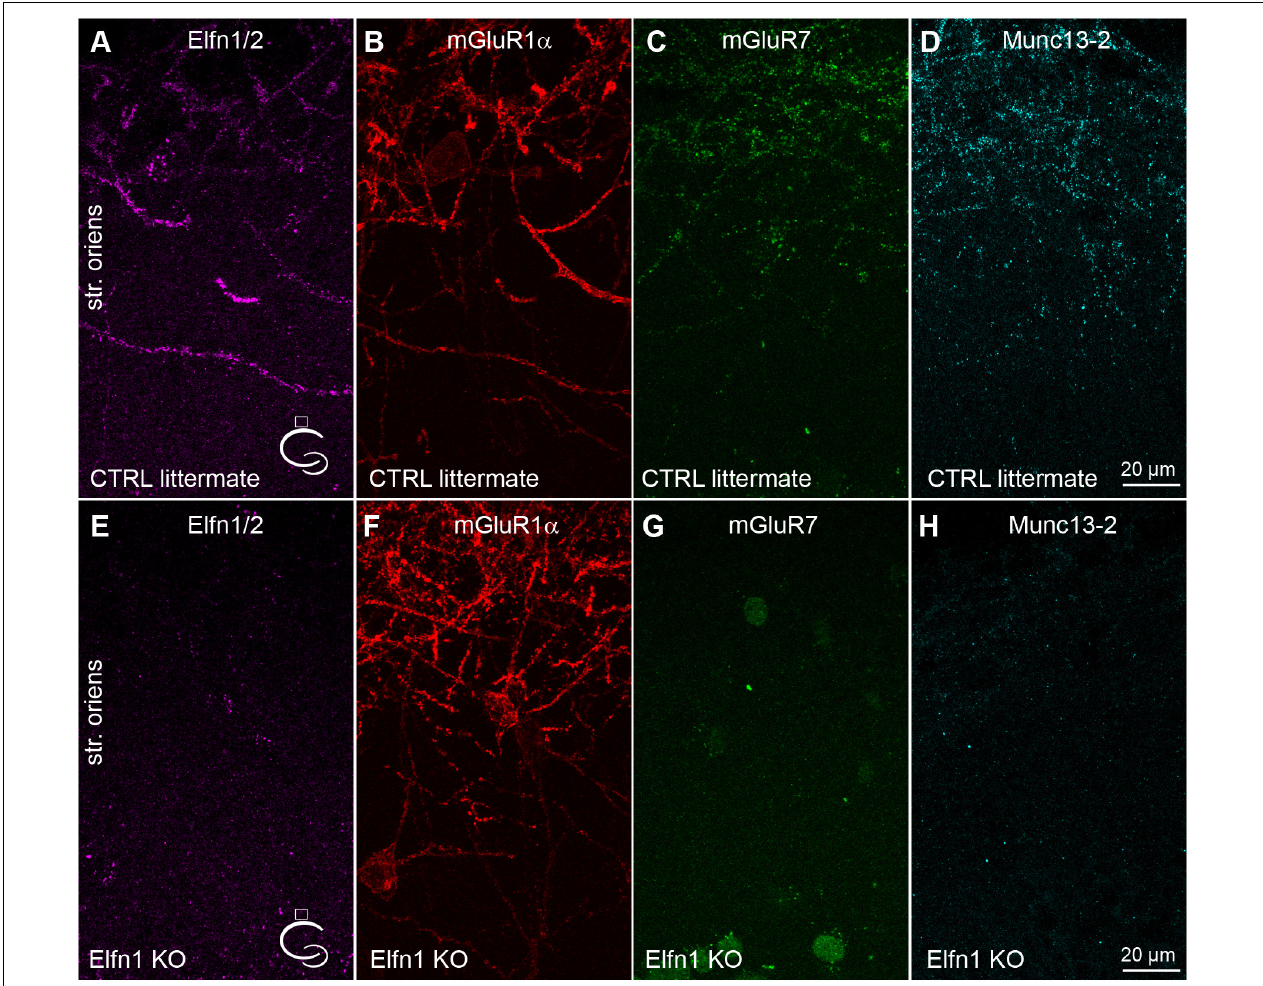
FIGURE 2 | Munc13-2 and mGluR7 are missing in Elfn1 knock-out mice. (A–D) Immunolabeling for Elfn1/2 (A) , mGluR1 α (B) , mGluR7 (C) and Munc13-2 (D) in the dorsal CA1 region of a littermate control mouse shows intense labeling of IN dendrites in the str. oriens. (E–H) same as (A–D) in an Elfn1 KO mouse. No specific immunolabeling is detected for Elfn1/2 (E) , mGluR7 (G) and Munc13-2 (H) . Cartoons indicate the location of the region. Maximum intensity projection of 20 confocal images separated by 1 µ m. str. oriens, stratum